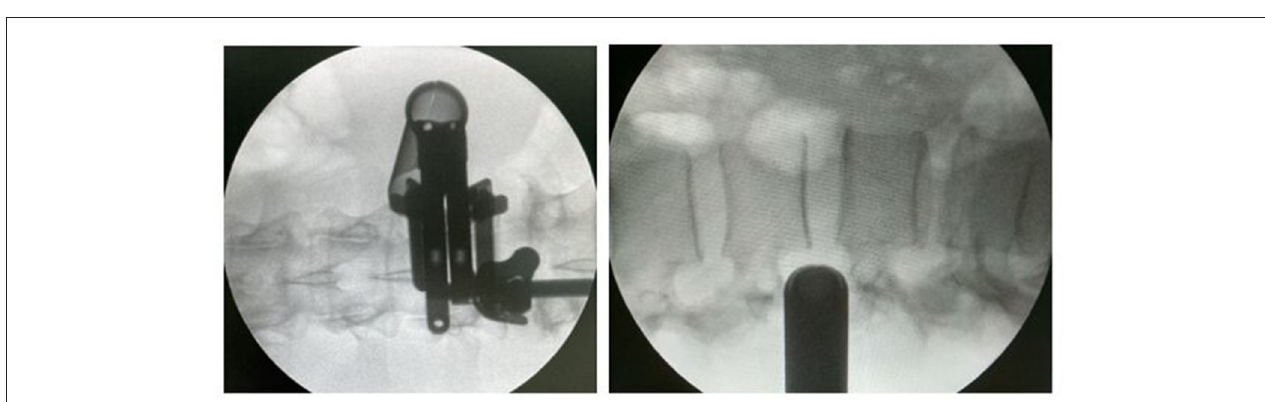
FIGURE 3 | Direct and lateral X-ray control during the